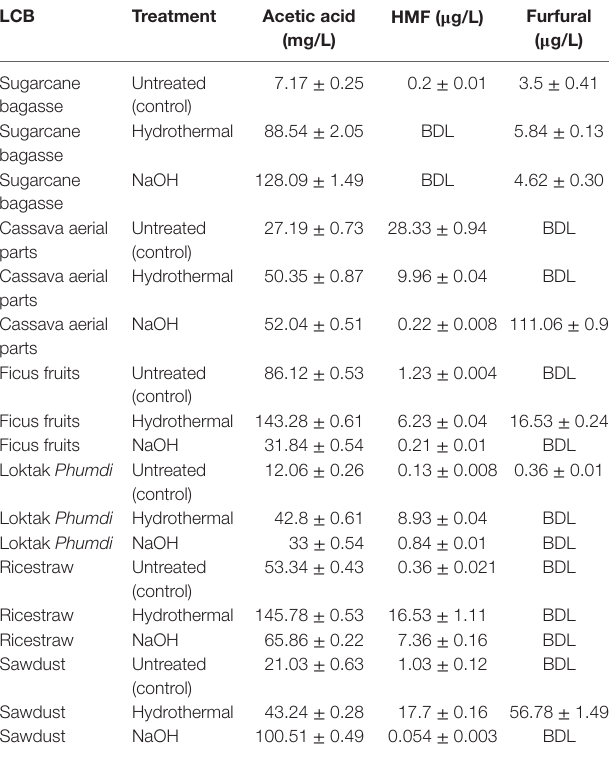
TaBle 2 | Content of three major inhibitors in liquor fraction of six lignocellulosic biomass (LCB) before (control) and after hydrothermal and sodium hydroxide (NaOH)